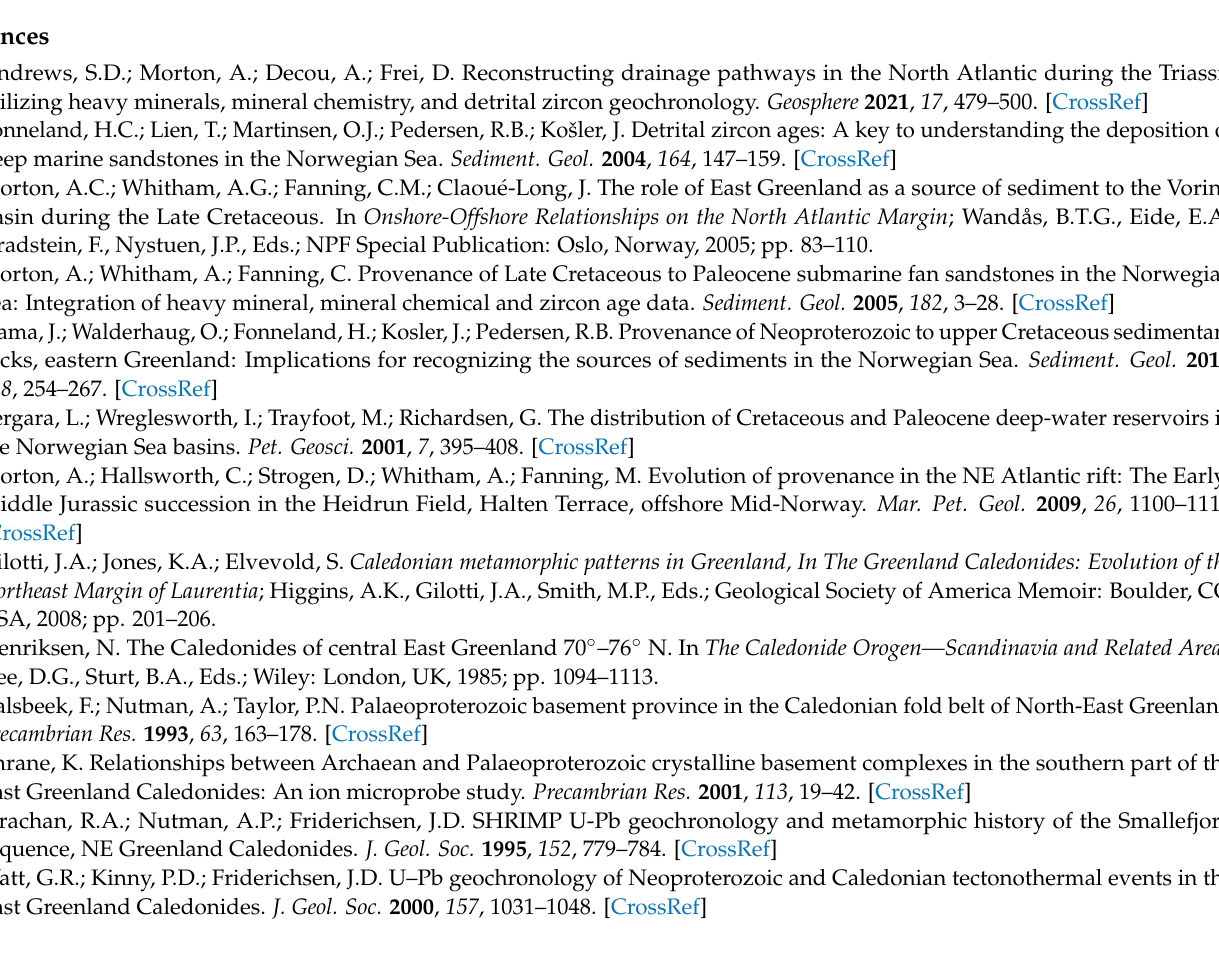
mineral data; Table S4: Amphibole chemistry data; Table S5: Garnet chemistry data; Table S6: Rutile chemistry